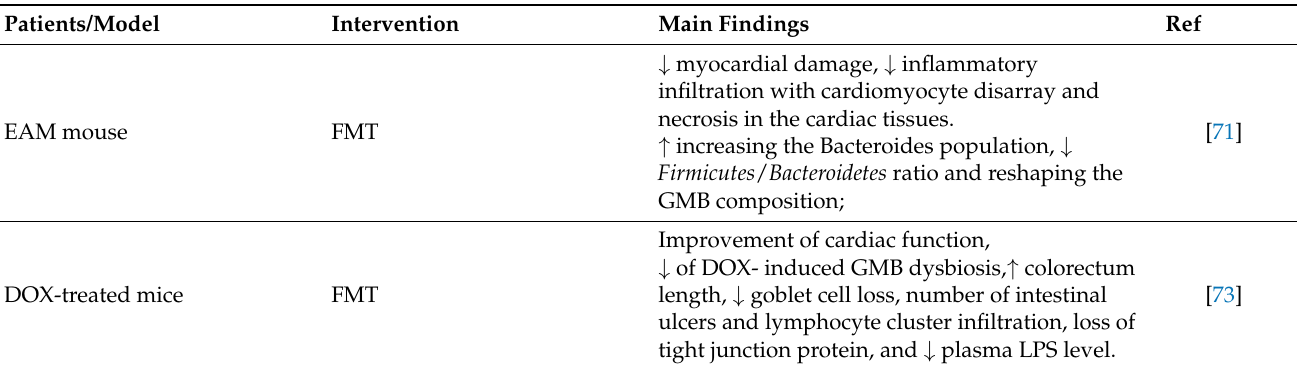
Table 3. The main results of research on modulation of gut microbiota and its metabolites for the prevention and treatment of congestive heart